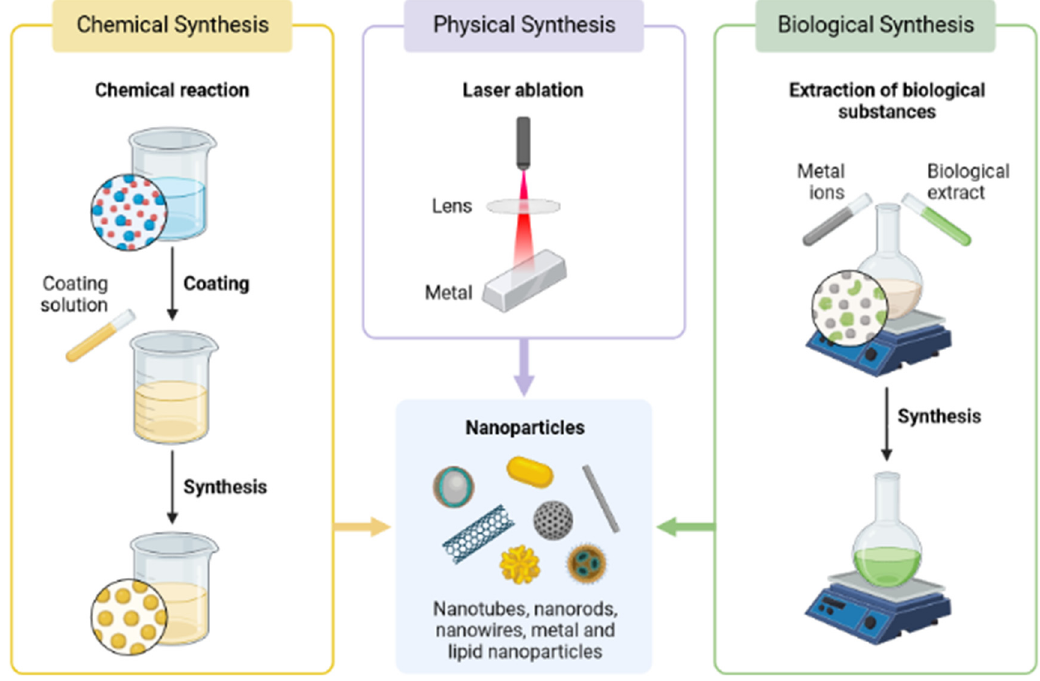
Figure 2. Nanoparticles Methods of Production. Table 2. Comparative evaluation of SeNPs production methods.